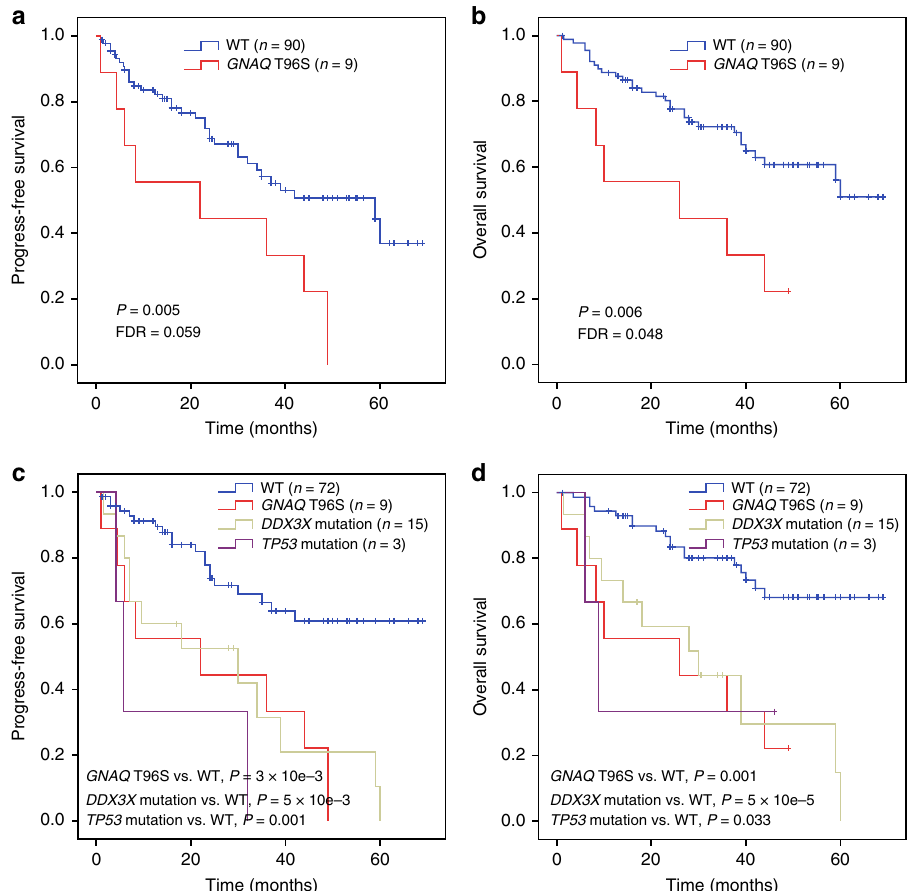
Fig. 7 GNAQ T96S mutations predict a worse prognosis in NKTCL. a , b Progression-free survival ( a ) and overall survival ( b ) of NKTCL patients with GNAQ T96S mutations ( n = 9) or wild-type (WT, n = 90). c , d Progression-free survival ( c ) and overall survival ( d ) of patients according to the mutation status of DDX3X , GNAQ , and TP53 . Patients were divided into four groups: those with GNAQ T96S mutations ( n = 9), DDX3X mutations ( n = 15), or TP53 mutations ( n = 3) and those without mutations in any of these three genes (WT, n = 72). Two individuals with both DDX3X and TP53 mutations were grouped into the DDX3X cohort. One individual with both GNAQ T96S and TP53 mutations was grouped into the GNAQ T96S cohort. Survival curves were estimated with the Kaplan – Meier method and compared using a two-sided log-rank